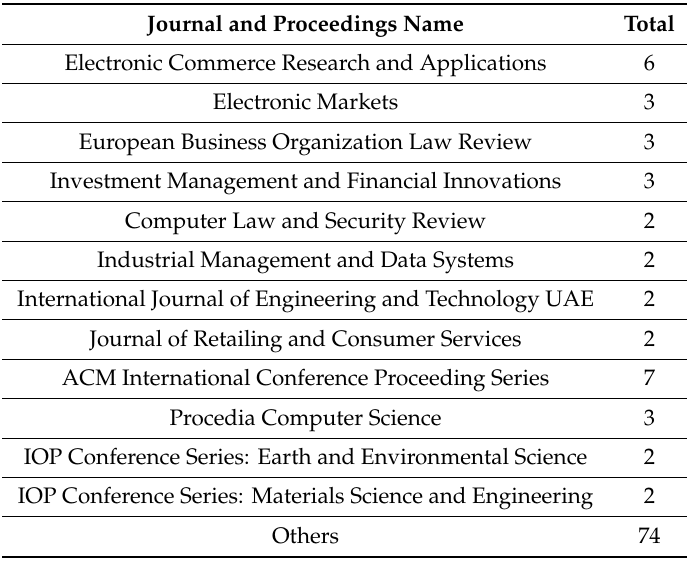
Table 4. Classification of articles by